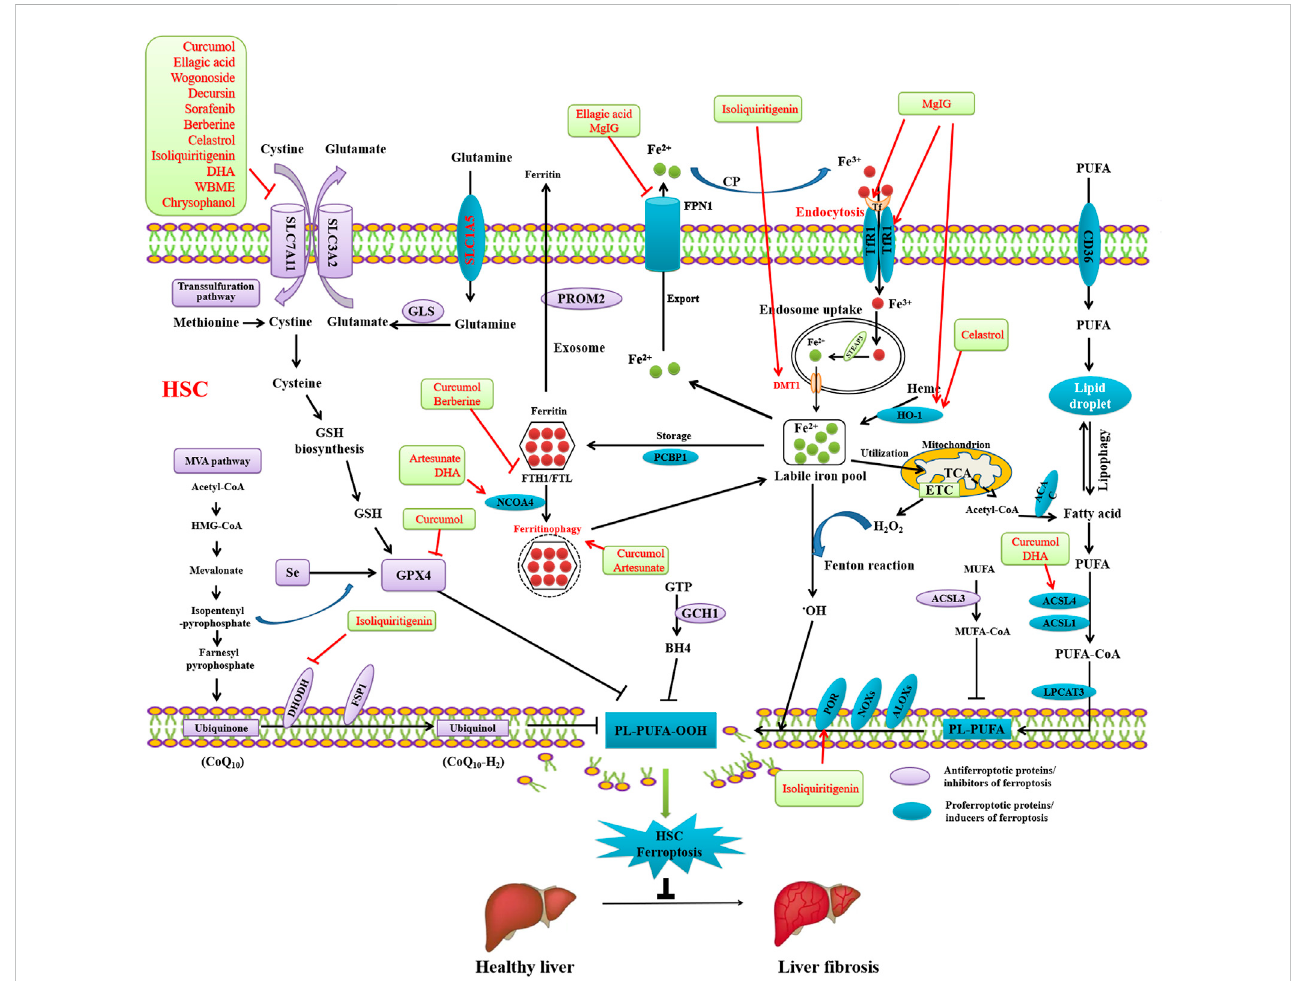
Reversing liver fi brosis through inducing ferroptosis by bioactivative compounds in HSCs. Curcumol, ellagic acid, wogonoside, decursin, sorafenib, berberine, celastrol, isoliquiritigenin, DHA, WBME, and chrysophanol alleviate liver fi brosis through inducing ferroptosis by inhibiting SLC7A11. Curcumol inhibits GPX4, therebyinducing HSCs ferroptosis to alleviateliver fi brosis. Isoliquiritigenin inhibits DHODH and upregulates POR, therebyinducing ferroptosis to alleviate liver fi brosis. Artesunate and DHA induces NCOA4-mediated ferritinophagy to induce ferroptosis and alleviate liver fi brosis. Curcumol and DHA induced ACSL4-dependant ferroptosis to alleviate liver fi brosis. Berberine and curcumol alleviate liver fi brosis through inhibiting FTH1/FTL. Ellagic acid and MgIG downregulates FPN1 to induce ferroptosis and alleviate liver fi brosis. MgIG upregulates TfR1 and HO-1 to induce ferroptosis and alleviate liver fi brosis. Celastrol also upregulates HO-1 to induce ferroptosis and alleviate liver fi